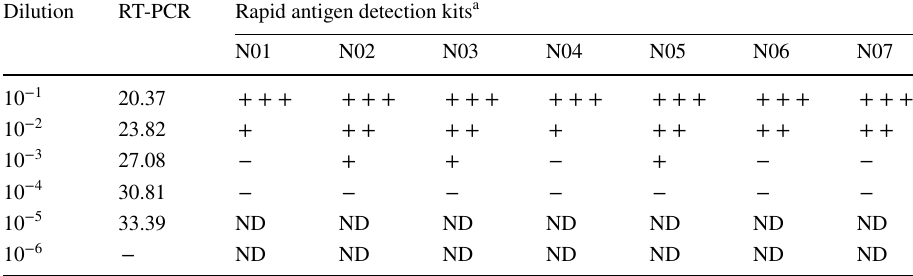
Table 2 Comparison of limit of detection for seven rapid antigen detection kits to detect SARS- CoV-2